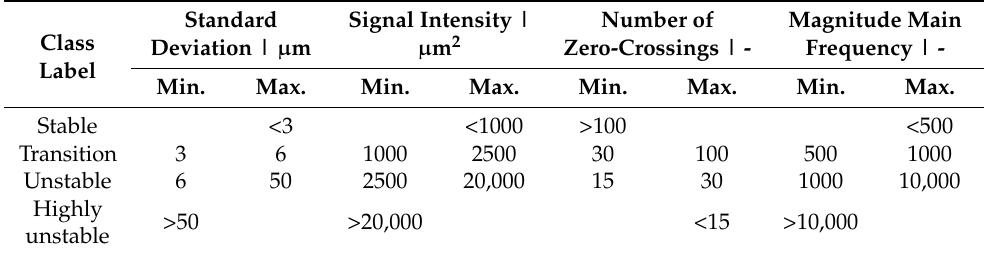
Table 9. Upper and lower limits of the parameters evaluated for stability classification.